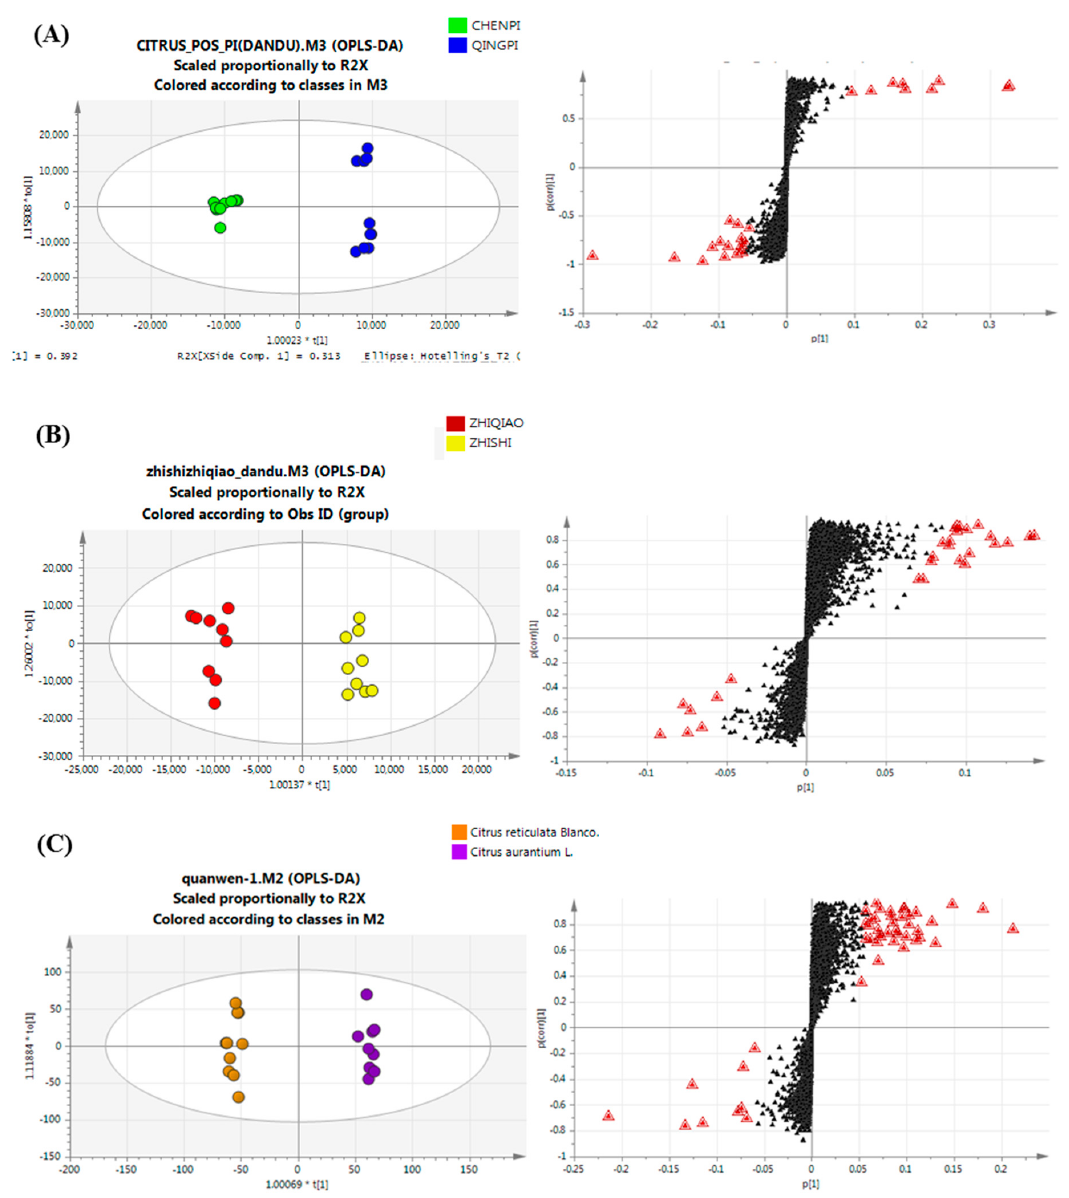
Figure 5. OPLS-DA score plots and loading S-plots of metabolites analyzed by UPLC-Q-TOF/MS in Citrus samples with the QP/CP group, ZS/ZQ group and CR/CA group. ( A ) Qingpi vs. Chenpi group; ( B ) Zhishi vs Zhiqiao group; ( C ) Citrus reticulate Blanco vs. Citrus aurantium L. group. The most differential compounds are marked with red triangles.